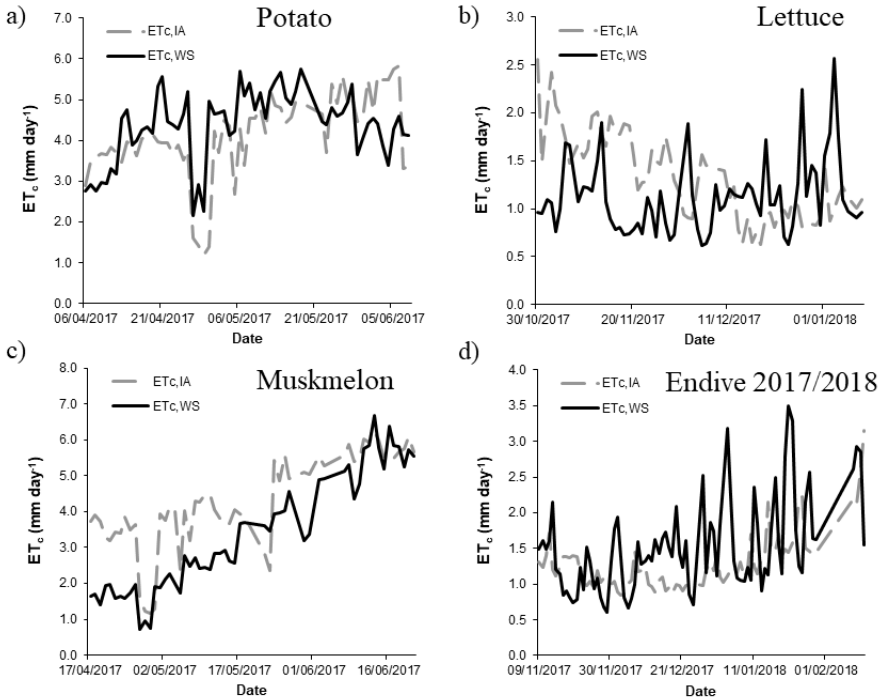
Figure 2. Evolution of crop evapotranspiration (ET c ) calculated using the weather records from the closest weather station and the crop coe ffi cients provided by the Murcia agricultural extension service (ET c , WS) and using Irrigation-Advisor (ET c , IA): ( a ) Potato; ( b ) Lettuce; ( c ) Muskmelon; ( d ) Endive 2017/2018.